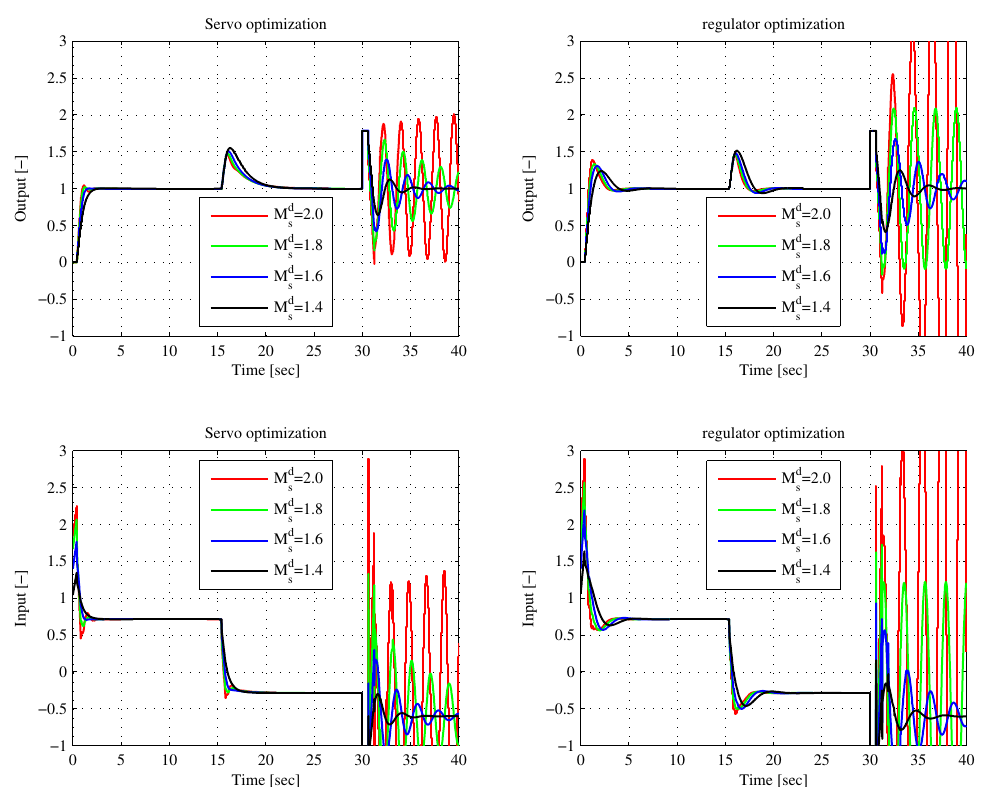
Figure 7. Output and input responses obtained using the proposed method for each M d s with model perturbation, where the system is disturbed after 15 s; left: servo optimization; right: regulator